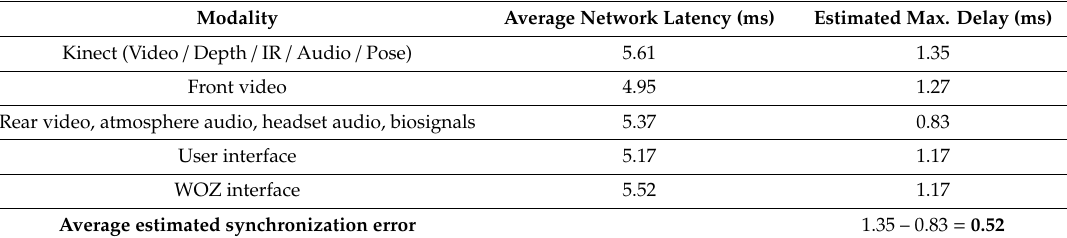
Table 2. Average network latency between recording modules and estimated maximum delay between